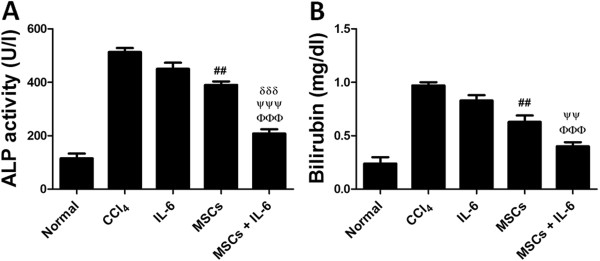
Liver function tests. A) Alkaline phosphatase in serum of all animal groups B) Bilirubin serum levels in all animal groups (n= 10/group). CCl4 vs IL-6 *p< 0.05, **p< 0.01 and ***p< 0.001, CCl4 vs MSCs #p< 0.05, ##p< 0.01 and ###p< 0.001, CCl4 vs MSCs + IL-6 ɸ p< 0.05, ɸ ɸ p< 0.01 and ɸ ɸ ɸ p< 0.001, IL-6 vs MSCs + IL-6 ψp< 0.05, ψψp< 0.01 and ψψψp< 0.001, MSCs vs MSCs + IL-6 δp< 0.05, δδp< 0.01 and δδδp< 0.001.